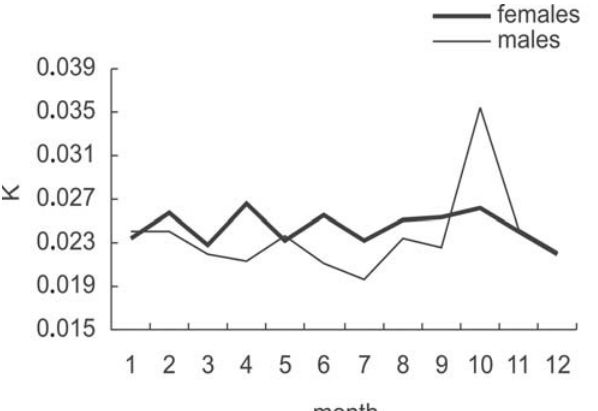
Fig. 6 . Monthly average condition factor (K) by sex for L. acutidens.